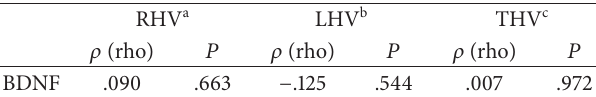
Table 5: Correlations between levels of BDNF and hippocampal volume controlling for intracranial volume. RHV a